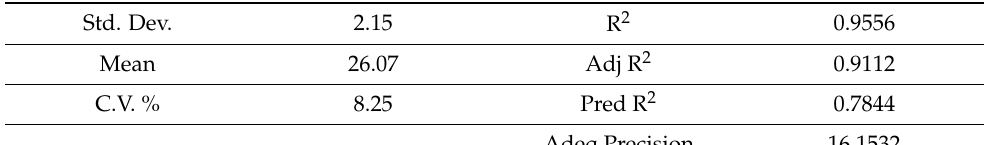
Table 3. Values of Regression